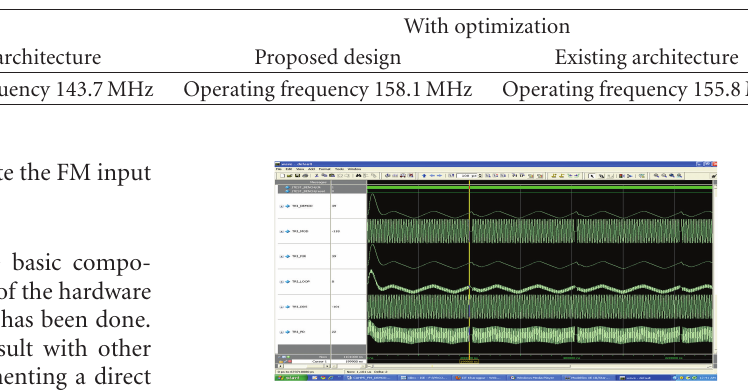
Figure 16: Simulation result of FM demodulator for Triangular wave modulated input.